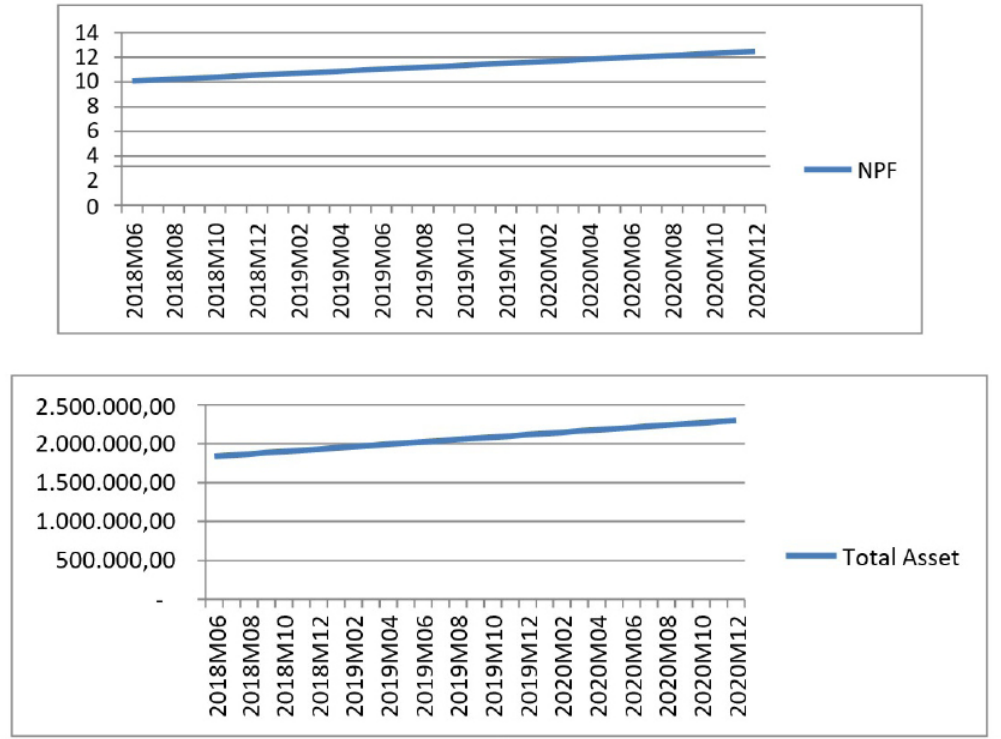
Figure 6: The Forecasting of Financial Inclusion in East Java through BPRS using Quality Indicator Source: Data Processed